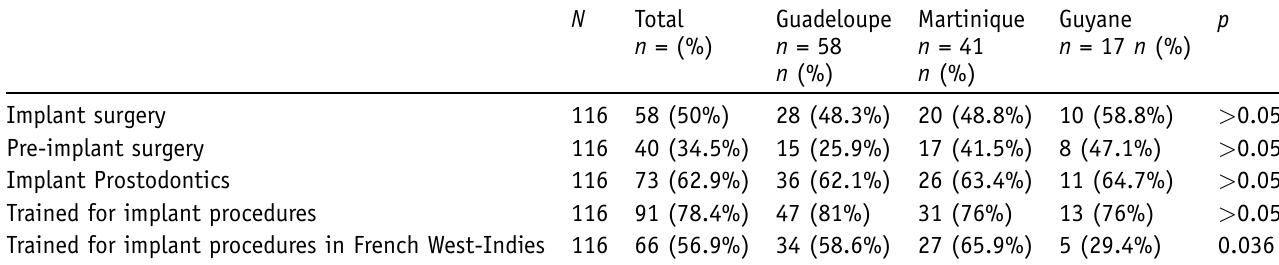
Table 2. Dental implant practices and training of dentists in Guadeloupe, Martinique and French Guyana.